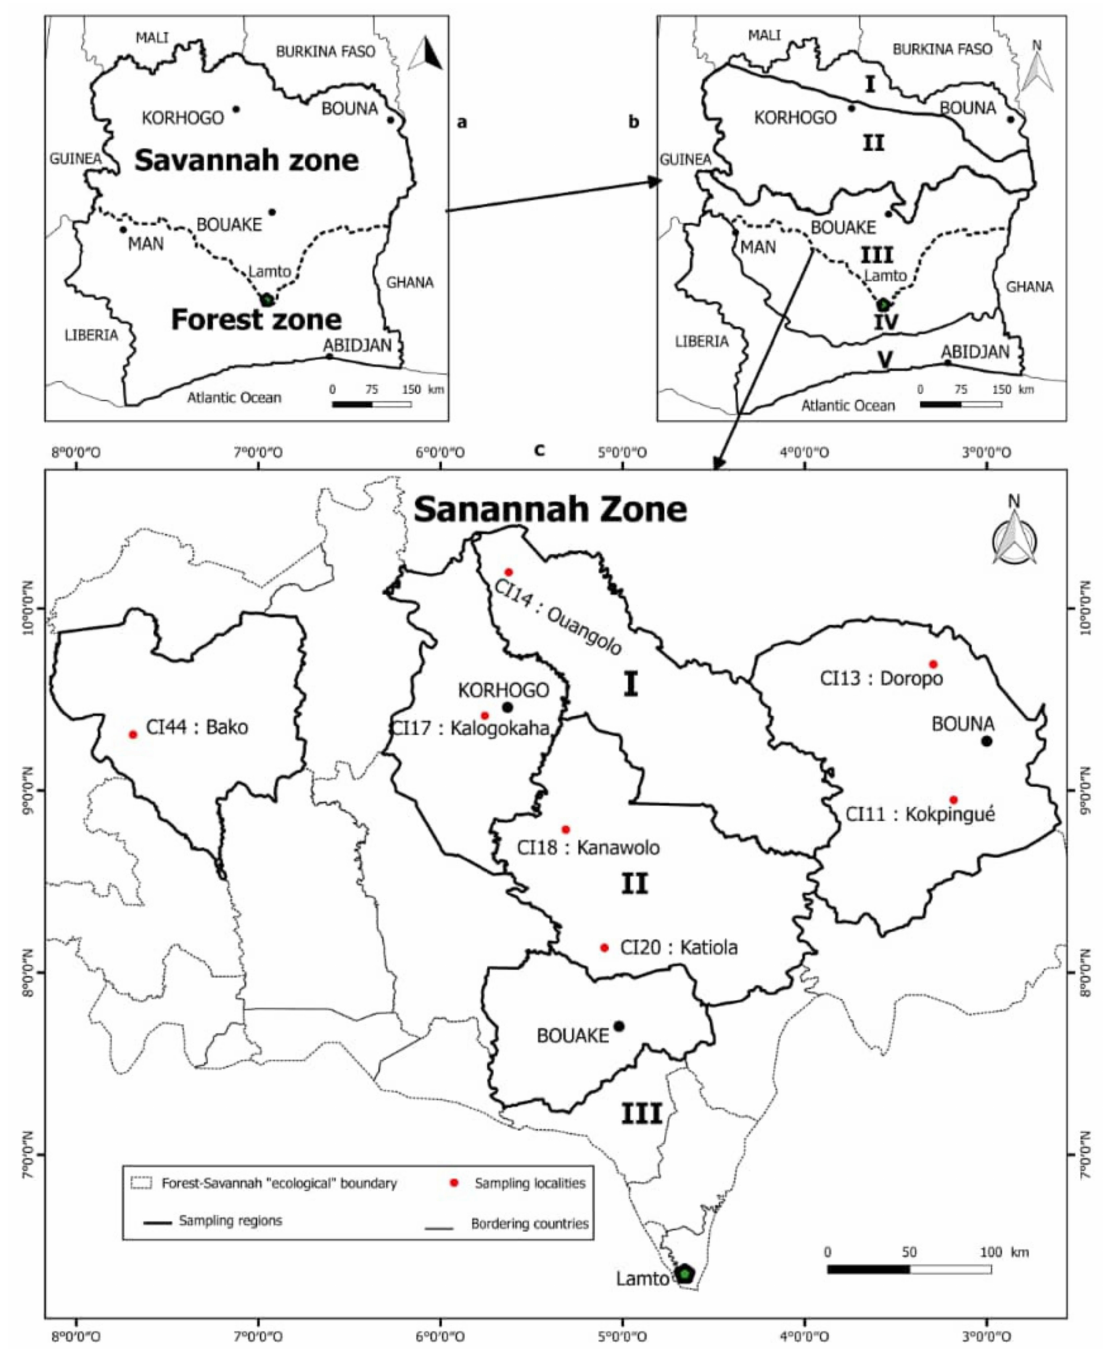
Figure 1. A map of C ô te d’Ivoire with ( a ) the two large agro-ecological regions, i.e., the forest and savannah, both of which are divided ( b ) into five zones (I, II, III, IV and V) according to the vegetation types. ( c ) The different localities surveyed in the savannah zones in Northern C ô te d’Ivoire are shown with red dots. Lamto is an ecological center for studying the tropical savannah in West Africa (http://lamto.free.fr/; accessed on 4 October